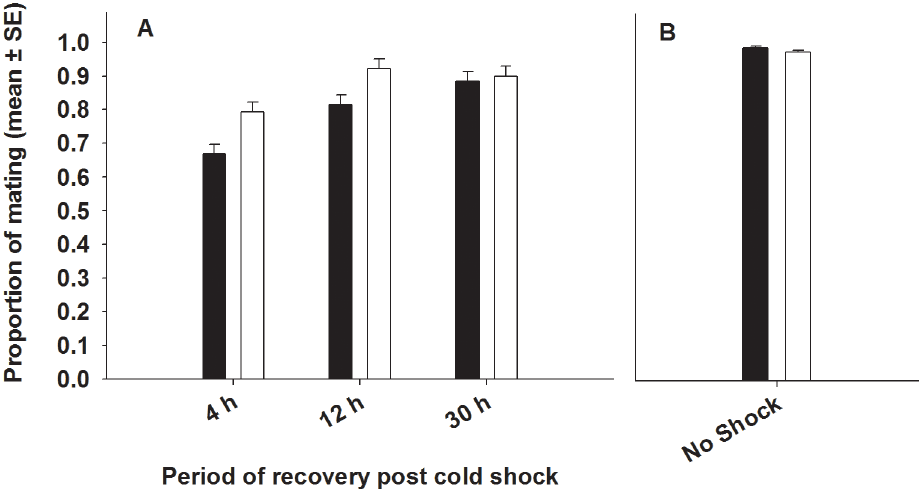
Fig 3. Effect of cold shock (A) or no shock (B) on mating success . Closed bars represent FCB and open bars represent FSB populations. (A) Selection and period had significant effects on mating success. However, Selection × period interaction was not significant. (B) Under no-shock treatment, there was no significant difference in mating success between FSB and FCB